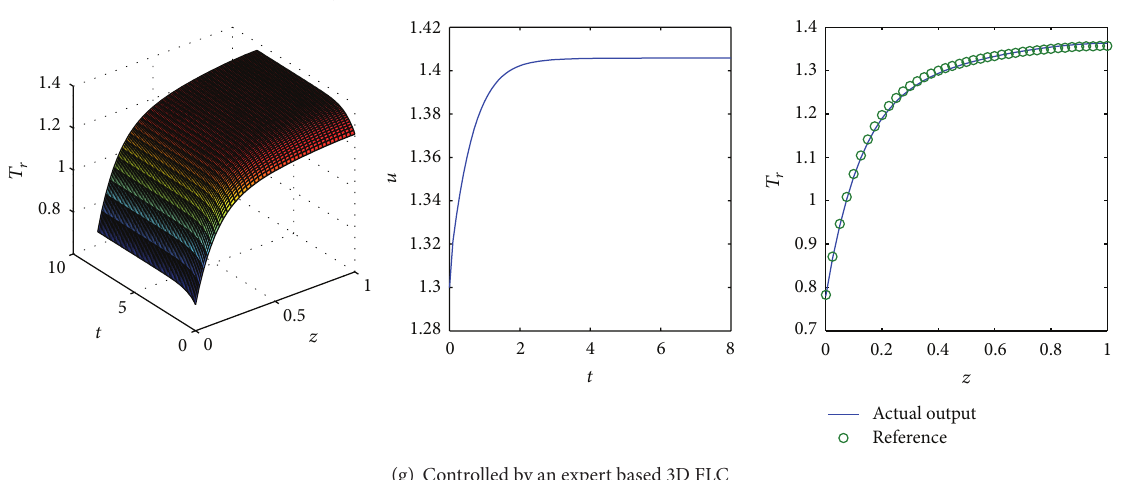
Figure 9: Control performance comparisons. From left to right in (a)–(g): catalyst temperature varying with time and space, manipulated input, and catalyst temperature at steady